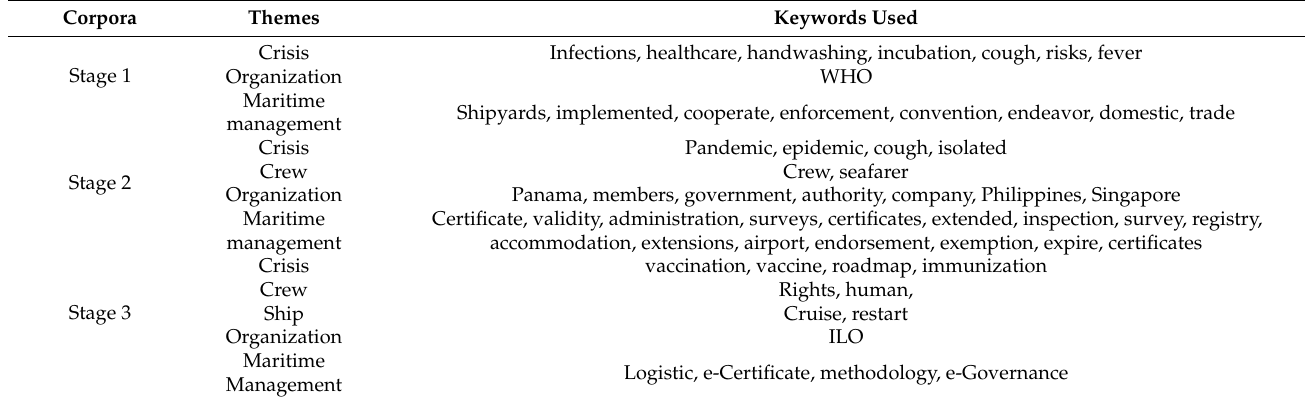
Table 7. Major themes.